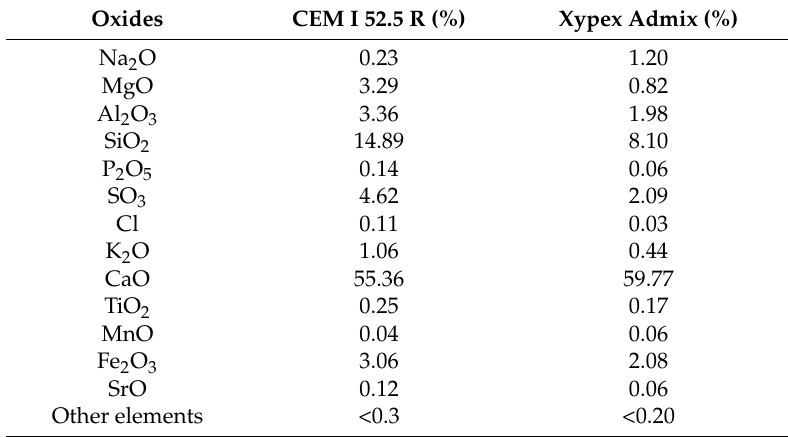
Figure 2. X-ray diffraction (XRD) spectra of cement type CEM I 52.5 R and Xypex Admix. Table 1. X-ray fluorescence (XRF) characterisation of CEM I 52.5 R and Xypex Table 1. X-ray fluorescence (XRF) characterisation of CEM I 52.5 R and Xypex Admix.